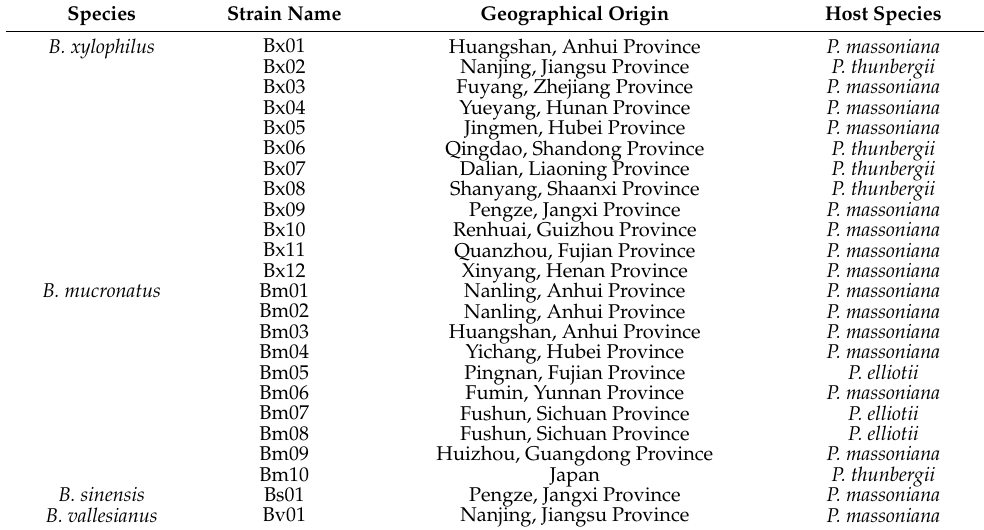
Table 1. Geographic origins and hosts of Bursaphelenchus species used in the study.